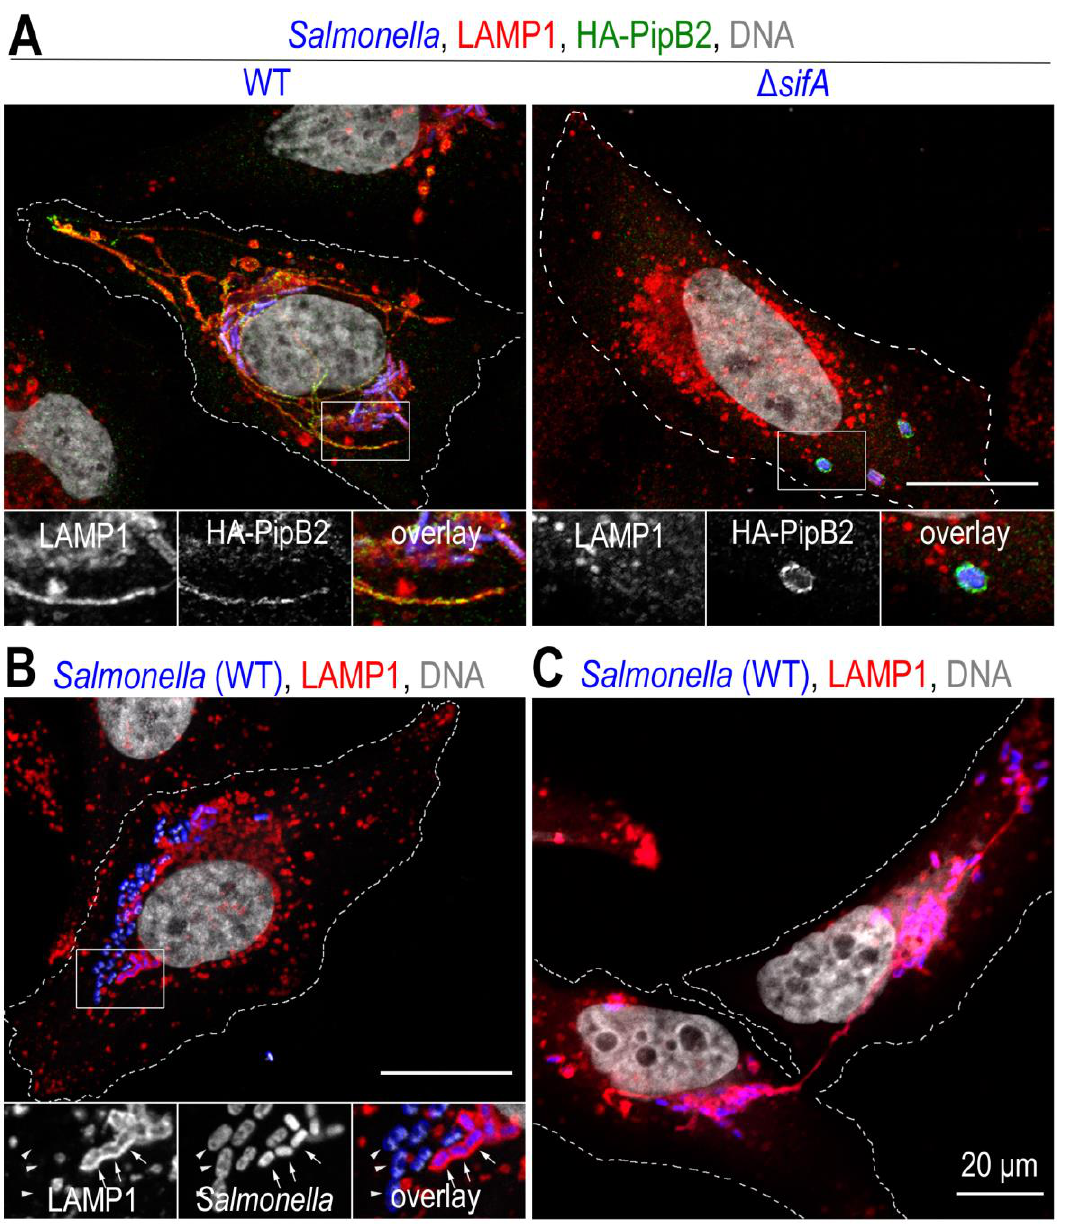
FIGURE 2: Salmonella induces a reorganization of the lysosomal compartment of the host cell . Confocal microscopy images, after immuno- labelling, illustrating phenotypes observed in HeLa cells at a late time (12 h) of infection. ( A ) In cells infected with wild-type Salmonella (WT), the presence of bacteria (blue) in the juxtanuclear region is observed. The bacteria are in a vacuolar compartment (SCV) with a membrane similar to that of lysosomes, illustrated here by LAMP1 labelling (red). Membrane tubules (SITs) stretching to the cell periphery are very characteristic of Salmonella -infected HeLa cells. Some effectors secreted by T3SS-2, here HA-tagged PipB2 (green), are present on SCVs and SITs. In the absence of SifA (∆ sifA ), the lysosome distribution of the infected cell appears to be little or not at all impaired. SCVs, which very often enclose several ∆ sifA bacteria, adopt a position midway between the nucleus and the plasma membrane and are characterized by very weak LAMP1 labelling but strong labelling for membrane effectors (PipB2). ( B ) Salmonella is commonly found in the cytosol of epitheli- al cells. The image shows bacteria that are not surrounded by LAMP1 labelling (arrowheads) and are larger than those present in SCVs (ar- rows). ( C ) The image illustrates the distribution of SCVs in the two sister cells following mitosis and the fact that a SIT connects the two groups of bacteria until the two cells separate. Scale bar, 20 or 10 μm for the magnified insets. This figure is composed of unpublished imag- OPEN ACCESS | www.microbialcell.com 29 Microbial Cell | FEBRUARY 2022 | Vol. 9 No. 2